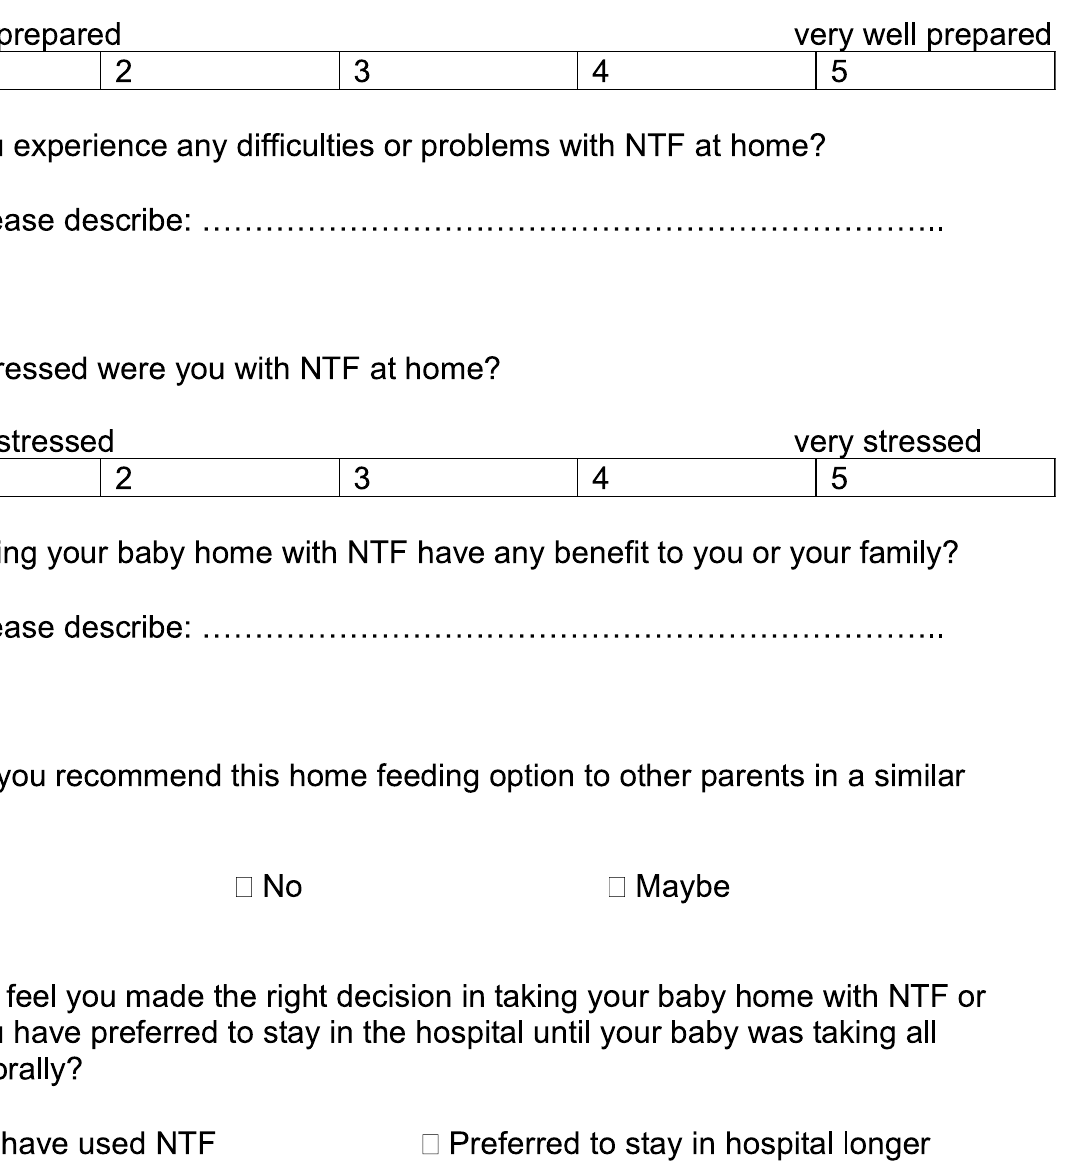
FIGURE 1 | Questionnaire, translated into English language.